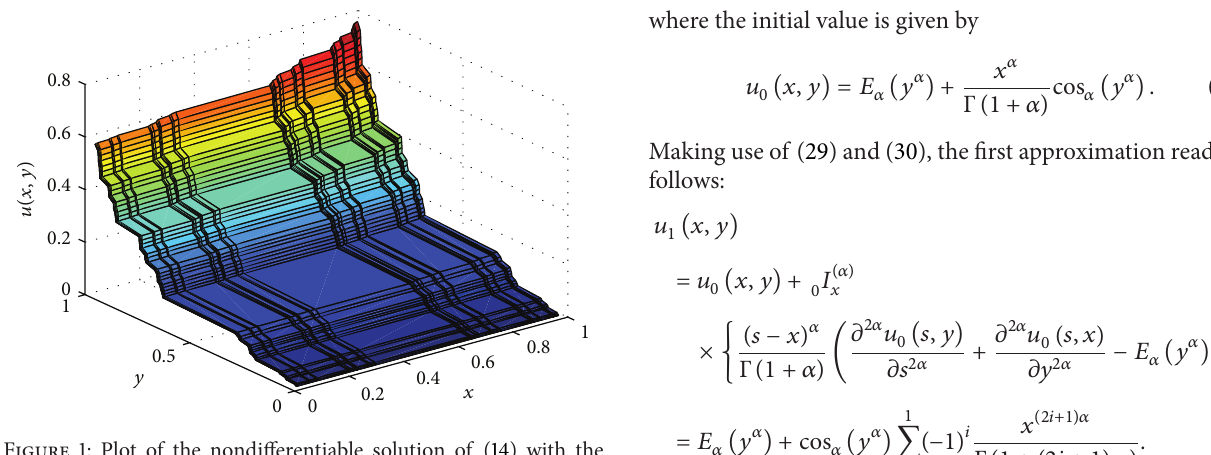
Figure 1: Plot of the nondifferentiable solution of (14) with the parameter 𝛼 = ln 2/ ln 3